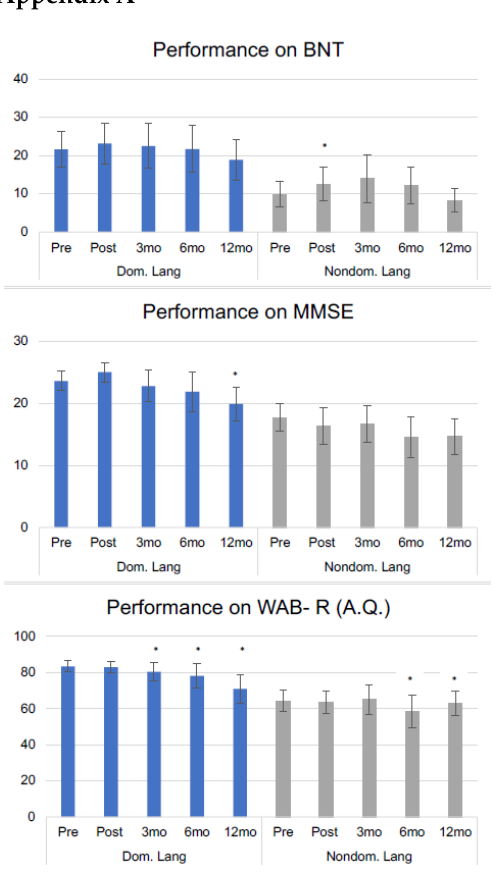
Figure A1. Performance from pre-treatment to each subsequent timepoint on a subset of cognitive and linguistic measures by language dominance. * Note. Standard error bars included for descrip- tive purposes. Significance determined via paired permutation tests. One-tailed tests used for BNT from pre to post-treatment; two-tailed tests used for all other timepoints/measures ( p < 0.05). Dom.= dominant language, Nondom.= nondominant language, BNT= Boston Naming Test; MMSE= Mini-Mental State Exam, WAB-R = Western Aphasia Battery-